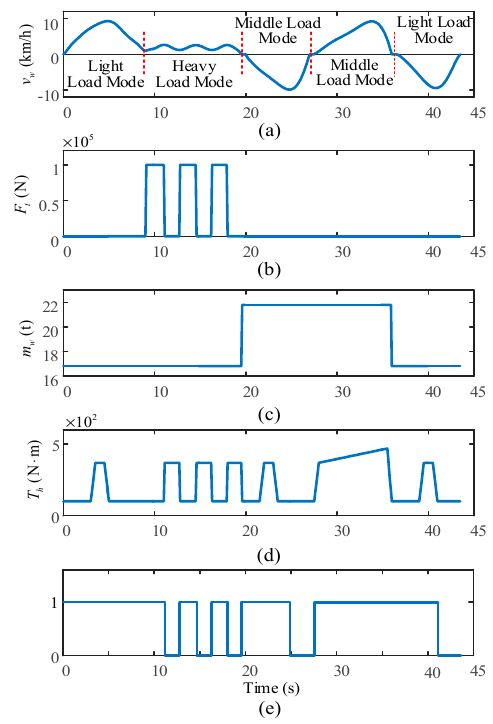
Figure 4. Operating mode of wheel loader. ( a ) Vehicle speed; ( b ) Thrusting resistance; ( c ) Whole vehicle mass; ( d ) Load torque of hydraulic pump; ( e ) Division of engine power between propelling transmission system and working hydraulics system. Table 1. Basic parameters of the wheel loader.